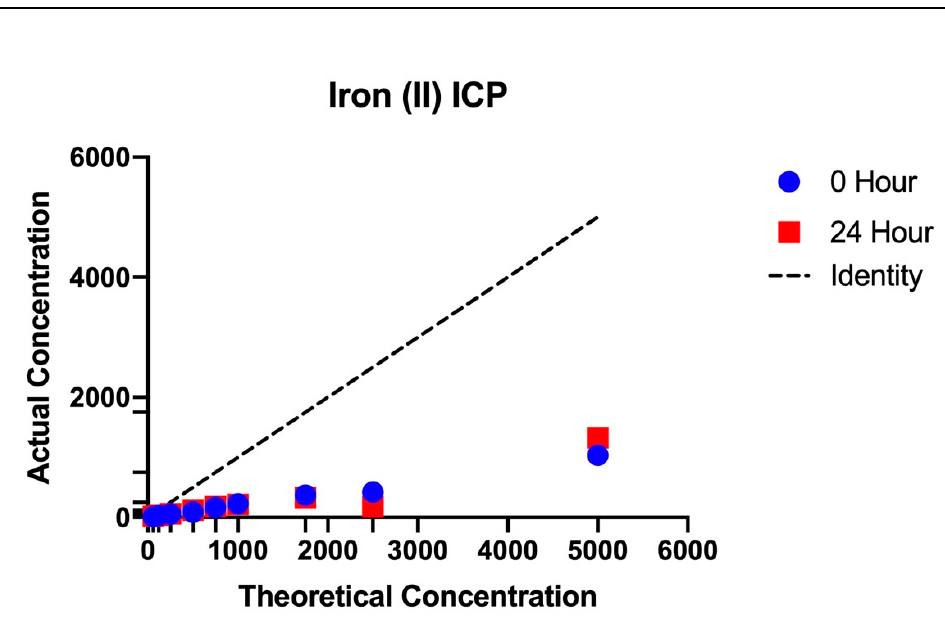
Figure A1. The actual amount of ionic iron (II) compared to the theoretical amount of iron (II) at 0 and 24 h in the bacterial medium.